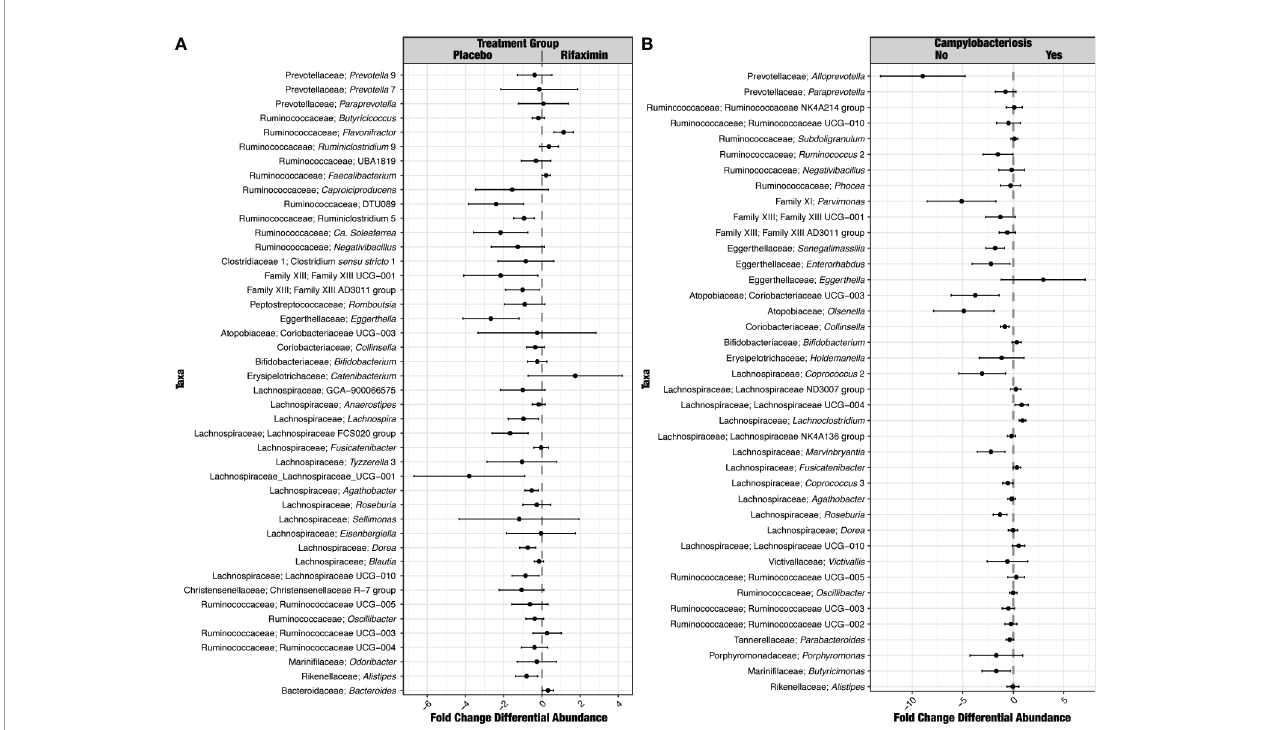
FIGURE 5 | Identi fi cation of ASVs that were differentially abundant between treatment groups (A) and study participants who did or did not develop campylobacteriosis (B) during the inpatient period. For differences between treatment groups (A) , taxa to the right of the plot were signi fi cantly greater in relative abundance in study participants in the rifaximin arm of the study. For differences between study participants who did or did not develop campylobacteriosis (B) , taxa to the right of the plot were signi fi cantly more abundant in those study participants who did develop